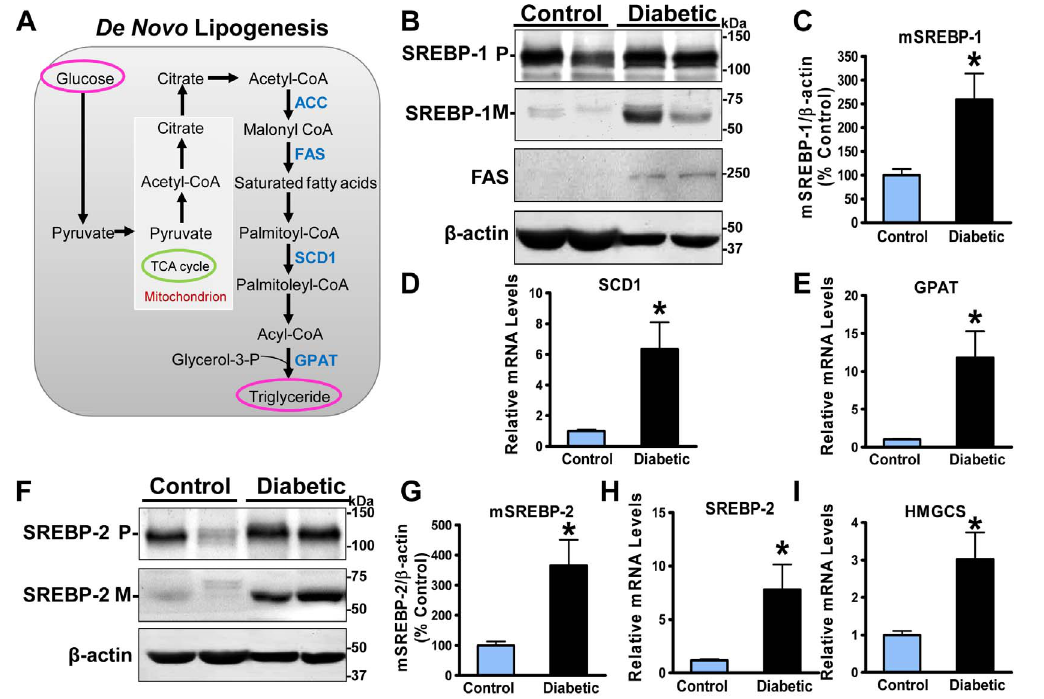
Figure 3. The cleavage processing of SREBP-1 and -2 as well as expression of their target genes are enhanced in the aorta of diabetic, atherosclerotic pigs. A . The transcriptional regulation of de novo lipogenic enzymes (blue color) by SREBP-1. B . The levels of mature, active form of SREBP-1 and expression of its target lipogenic enzyme, fatty acid synthase (FAS), are increased in the aorta of diabetic and atherosclerotic pigs. Total aortic lysates (100 m g proteins) were resolved by 8% SDS-PAGE and immunoblotted with the specific antibody to recognize both precursor ( P , , 125 kDa) and active mature ( M , , 68 kDa) forms of SREBP-1. Representative immunoblots of aortic tissues from two pigs in each group are shown. C . Densitometric quantification of the mature form of SREBP-1 is normalized to that of b -actin and expressed as relative levels to control pigs. D and E . The transcription of SREBP-1 target genes is elevated in the aorta of diabetic, atherosclerotic pigs. Total RNA was isolated from pig aorta, and mRNA levels of genes encoding stearoyl-CoA desaturase1 (SCD1) ( D ) and glycerol-3-phosphate acyltransferase (GPAT) ( E ) were determined by real-time PCR. F and G . The levels of the cleaved form of SREBP-2 protein were quantified by densitometry, normalized to those of b - actin, and expressed as relative levels to normal pigs. H and I . The mRNA amounts of SREBP-2 and its target gene, HMGCoA synthase (HMGCS), are elevated in atherosclerotic pigs. The mRNA levels of SREBP-2 and cholestrogenic genes were determined by real-time PCR, normalized to those of b - actin, and presented as relative levels to control pigs. Data were presented as the mean 6 S.E.M., n=3, *P , 0.05, vs control pigs.